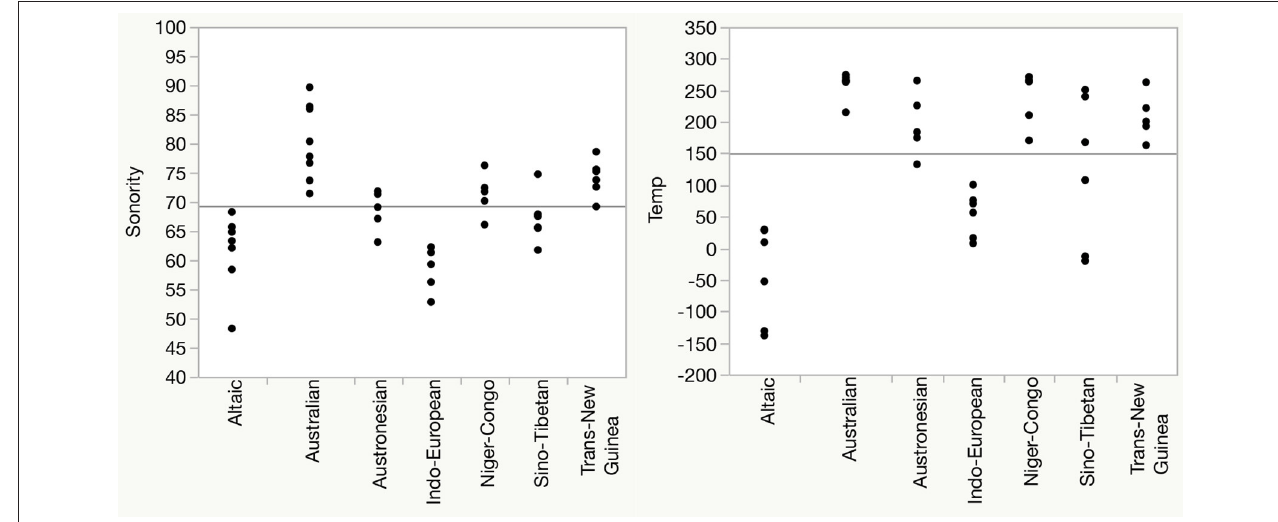
FIGURE 4 | Sonority scores (Left) and normalized mean annual temperature (relative to global mean), (Right) for languages in families with 5 or more languages in the